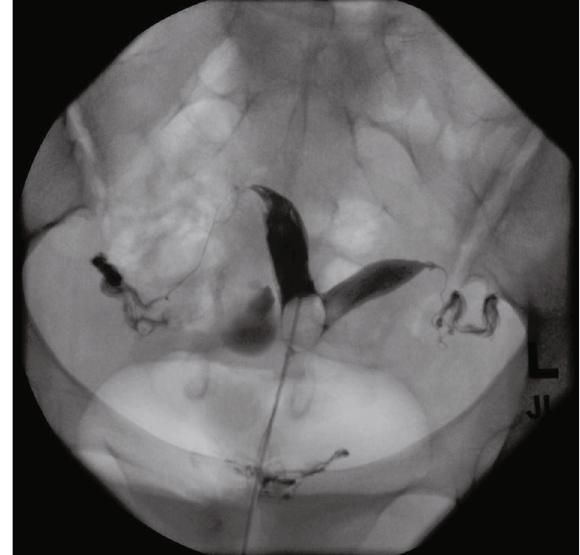
Figure 2: Hysterosalpingogram demonstrating two uterine cavities with patent fallopian tubes. It is not possible to di ff erentiate between a septate uterus and a bicornuate uterus from this image because the presence or absence of a fundal indentation cannot be observed.